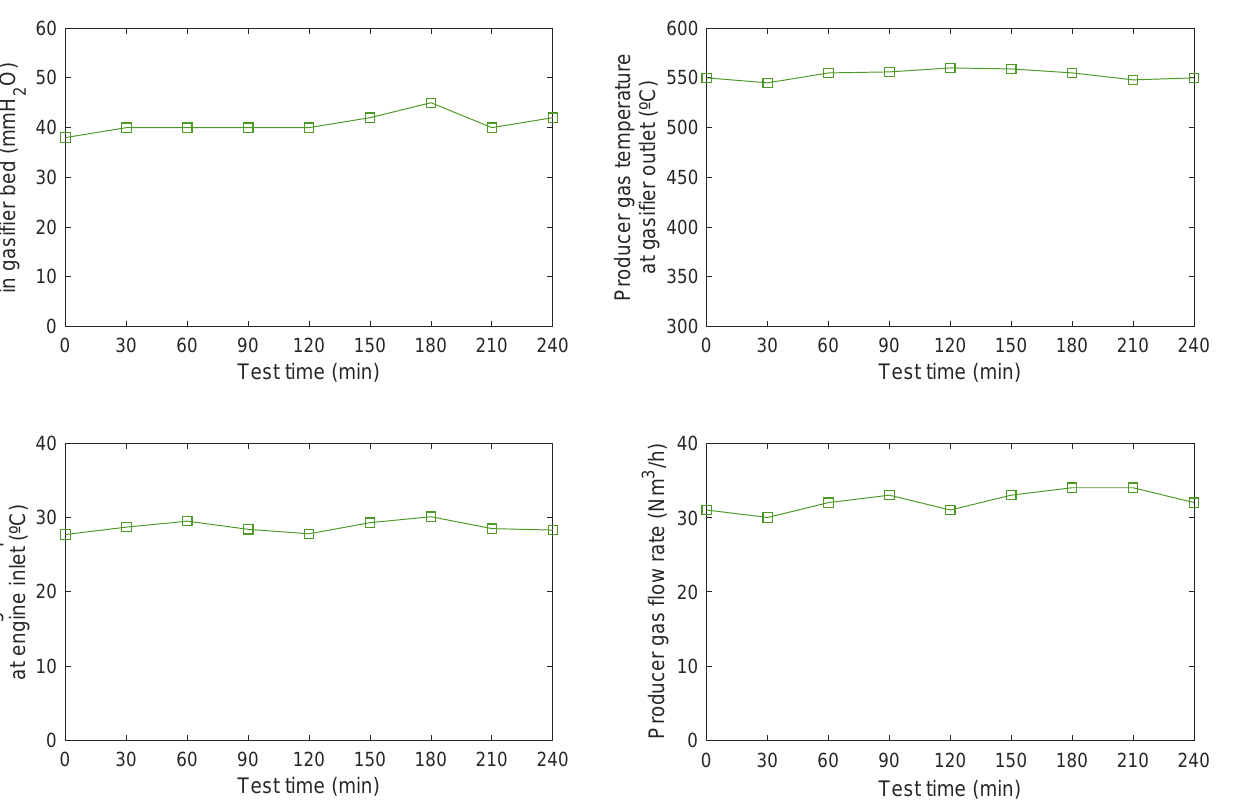
Figure 4. Monitored operating parameters of the gasification